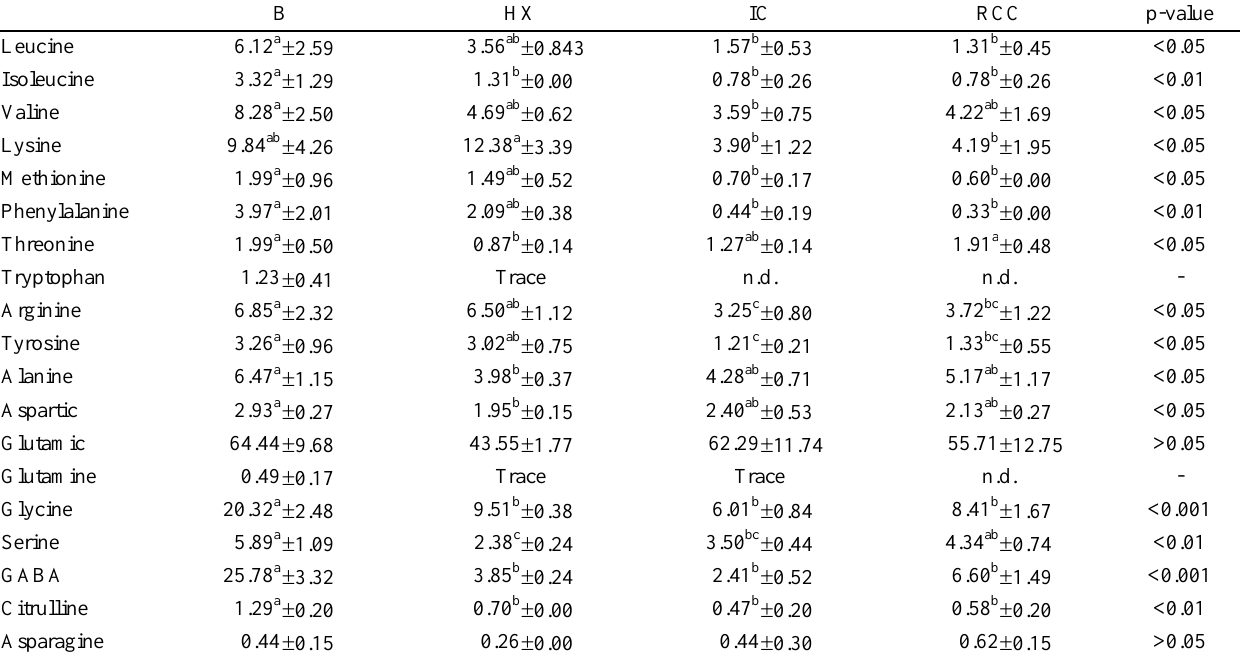
Table 3. Free amino acids (FAA) in buffalo (B), Holstein cross (HX), Indigenous cattle (IC) and Red Chittagong Cattle (RCC) milk; concentration (mg/kg milk) B